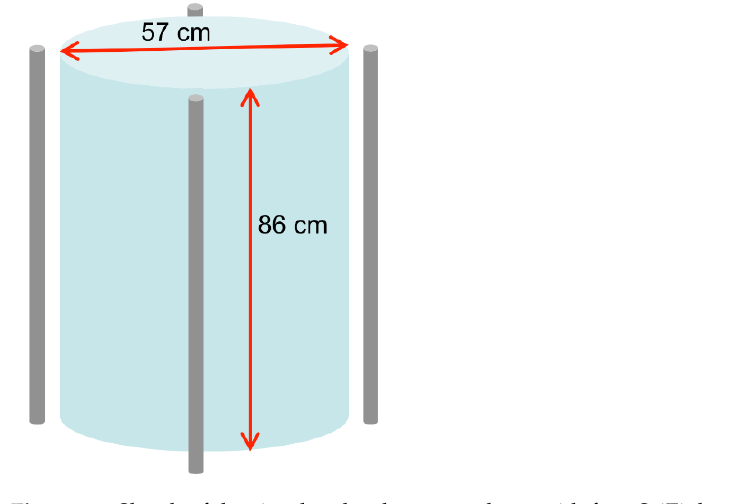
Figure 24. Sketch of the simulated radwaste package with four SciFi detectors around